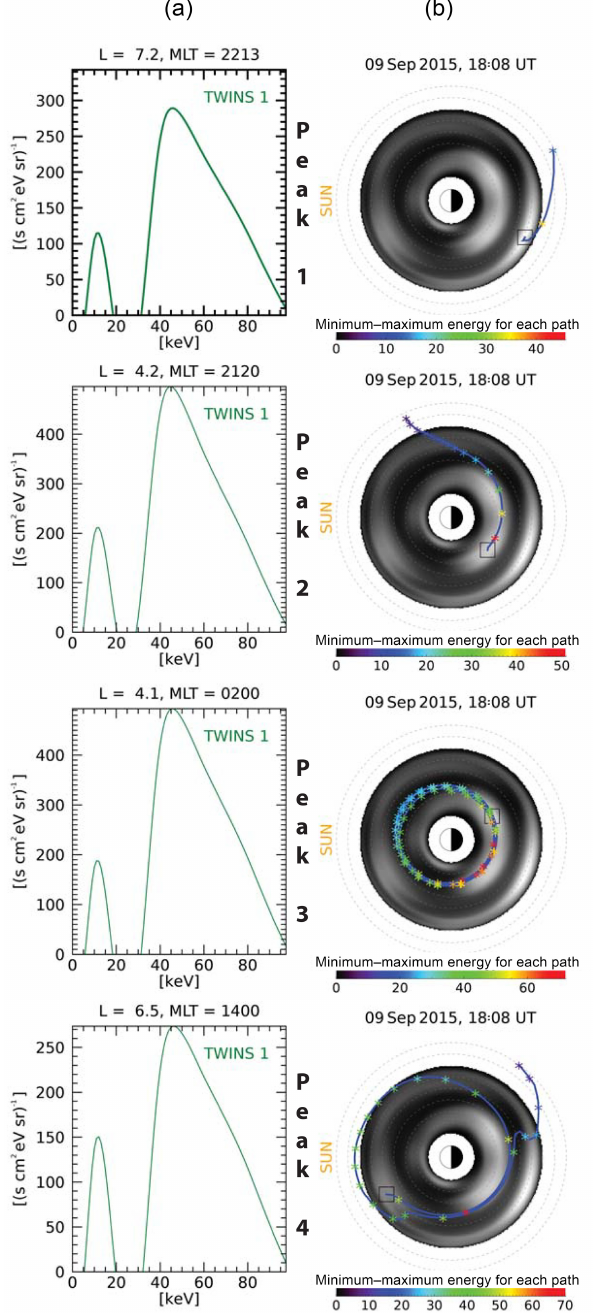
Figure 10. Paths of 46keV particles, the energy of protons at the maximum flux (see left column) that reach the four pressure peaks observed by TWINS as shown in Fig. 8. The observed pressure is shown in gray scale. The locations of the peaks are shown by black squares. The energy of the particle is indicated by the color of the stars that are spaced 10min apart. The unit of the color bars is keV. The energies span the range of the particle energies along their